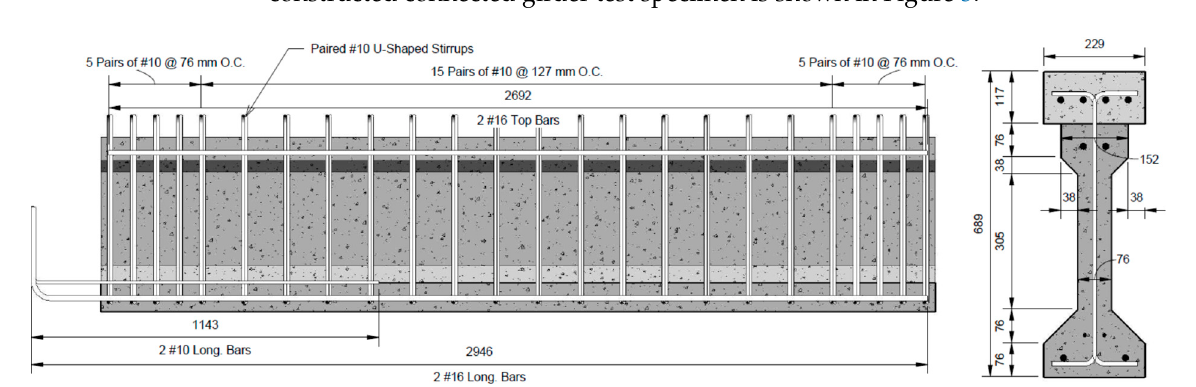
Figure 2. Individual girder dimensions and reinforcing layout.